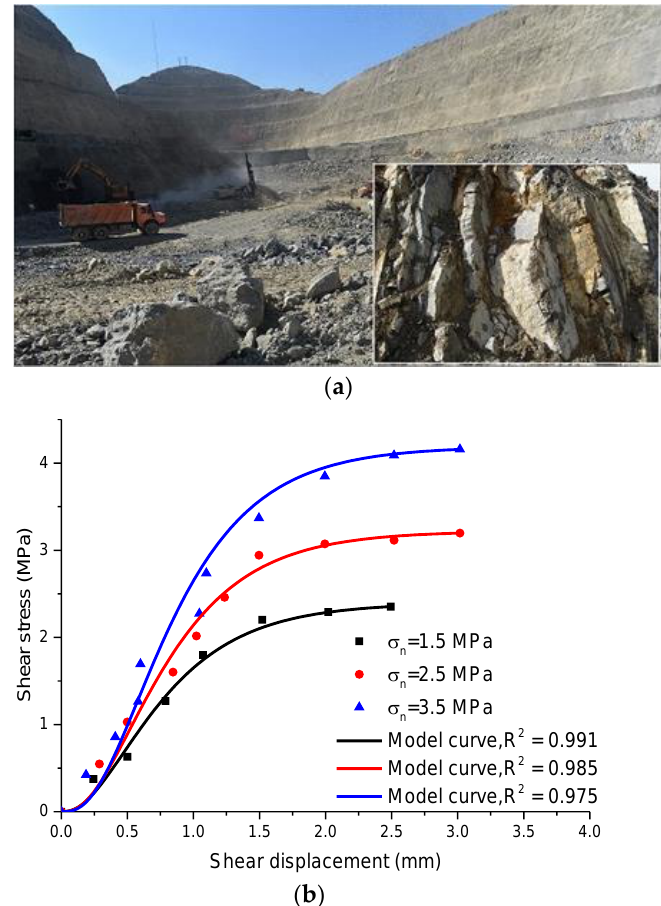
Figure 10. Comparison of in situ test results [77] with model curves, ( a ) sample collection, ( b ) shear stress - shear displacement curve.